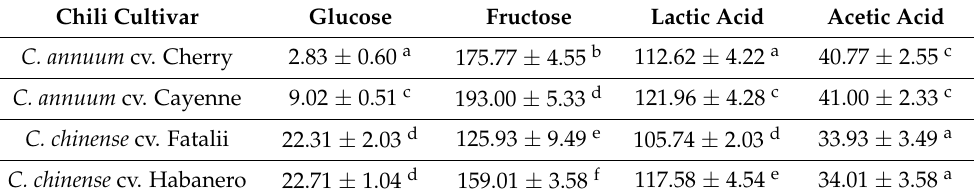
Table 5. Variation of sugar and organic acid content of freeze-dried fermented chili powder